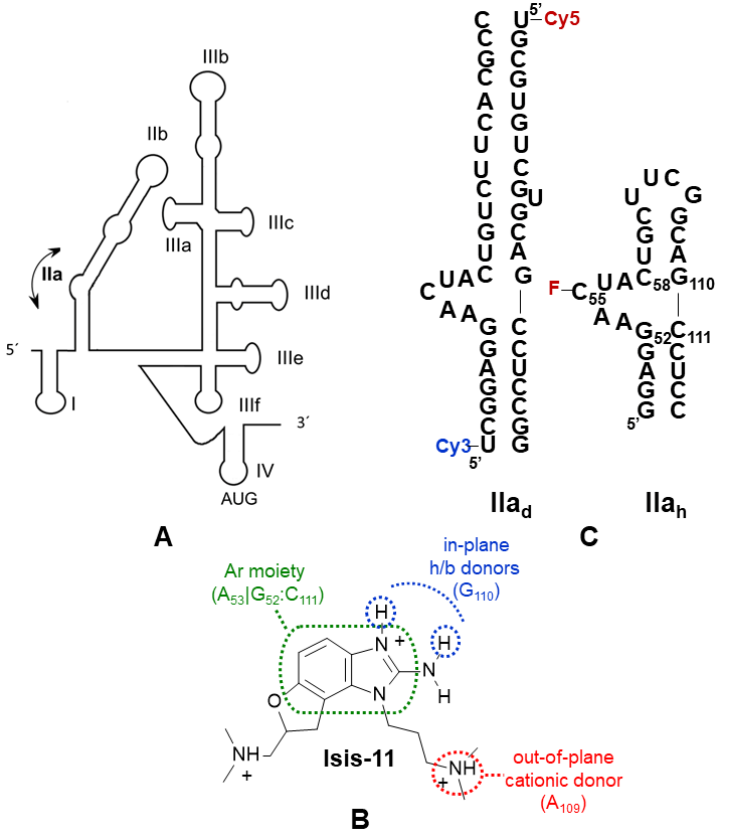
Figure 1. ( A ) Schematic representation of the HCV IRES, highlighting the flexible bending induced by the 5 ‐ nt AACUA bulge of subdomain IIa. ( B ) Chemical structure of benzimidazole inhibitor Isis ‐ 11 with a depiction of the features used to define the pharmacophore: an aromatic moiety stacking between the G 52 :C 111 pair and A 53 bulge base, two in ‐ plane hydrogen bonding donors interacting with the Hoogsteen edge of G 110 , and an out ‐ of ‐ plane positive charge located close to the A 109 phos ‐ phate group. The protonation state depicted in the figure is predicted for 80% of Isis ‐ 11 molecules at pH 7.0. ( C ) Secondary structure of the subdomain IIa d duplex used for FRET assays [12] and the subdomain IIa h hairpin utilized in NMR spectroscopy and fluorescence intensity experiments. The position of the cy3 and cy5 fluorophores of IIa d is indicated. For fluorescence intensity assays a flu ‐ orescein probe was linked to bulge residue C 55 of IIa h (indicated with F).